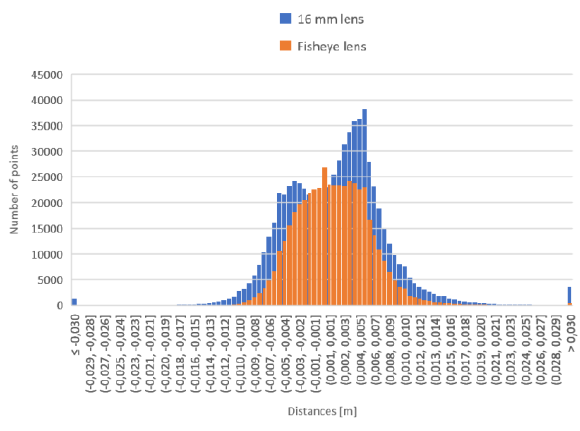
Figure 6. Histogram of set of distances for floor.